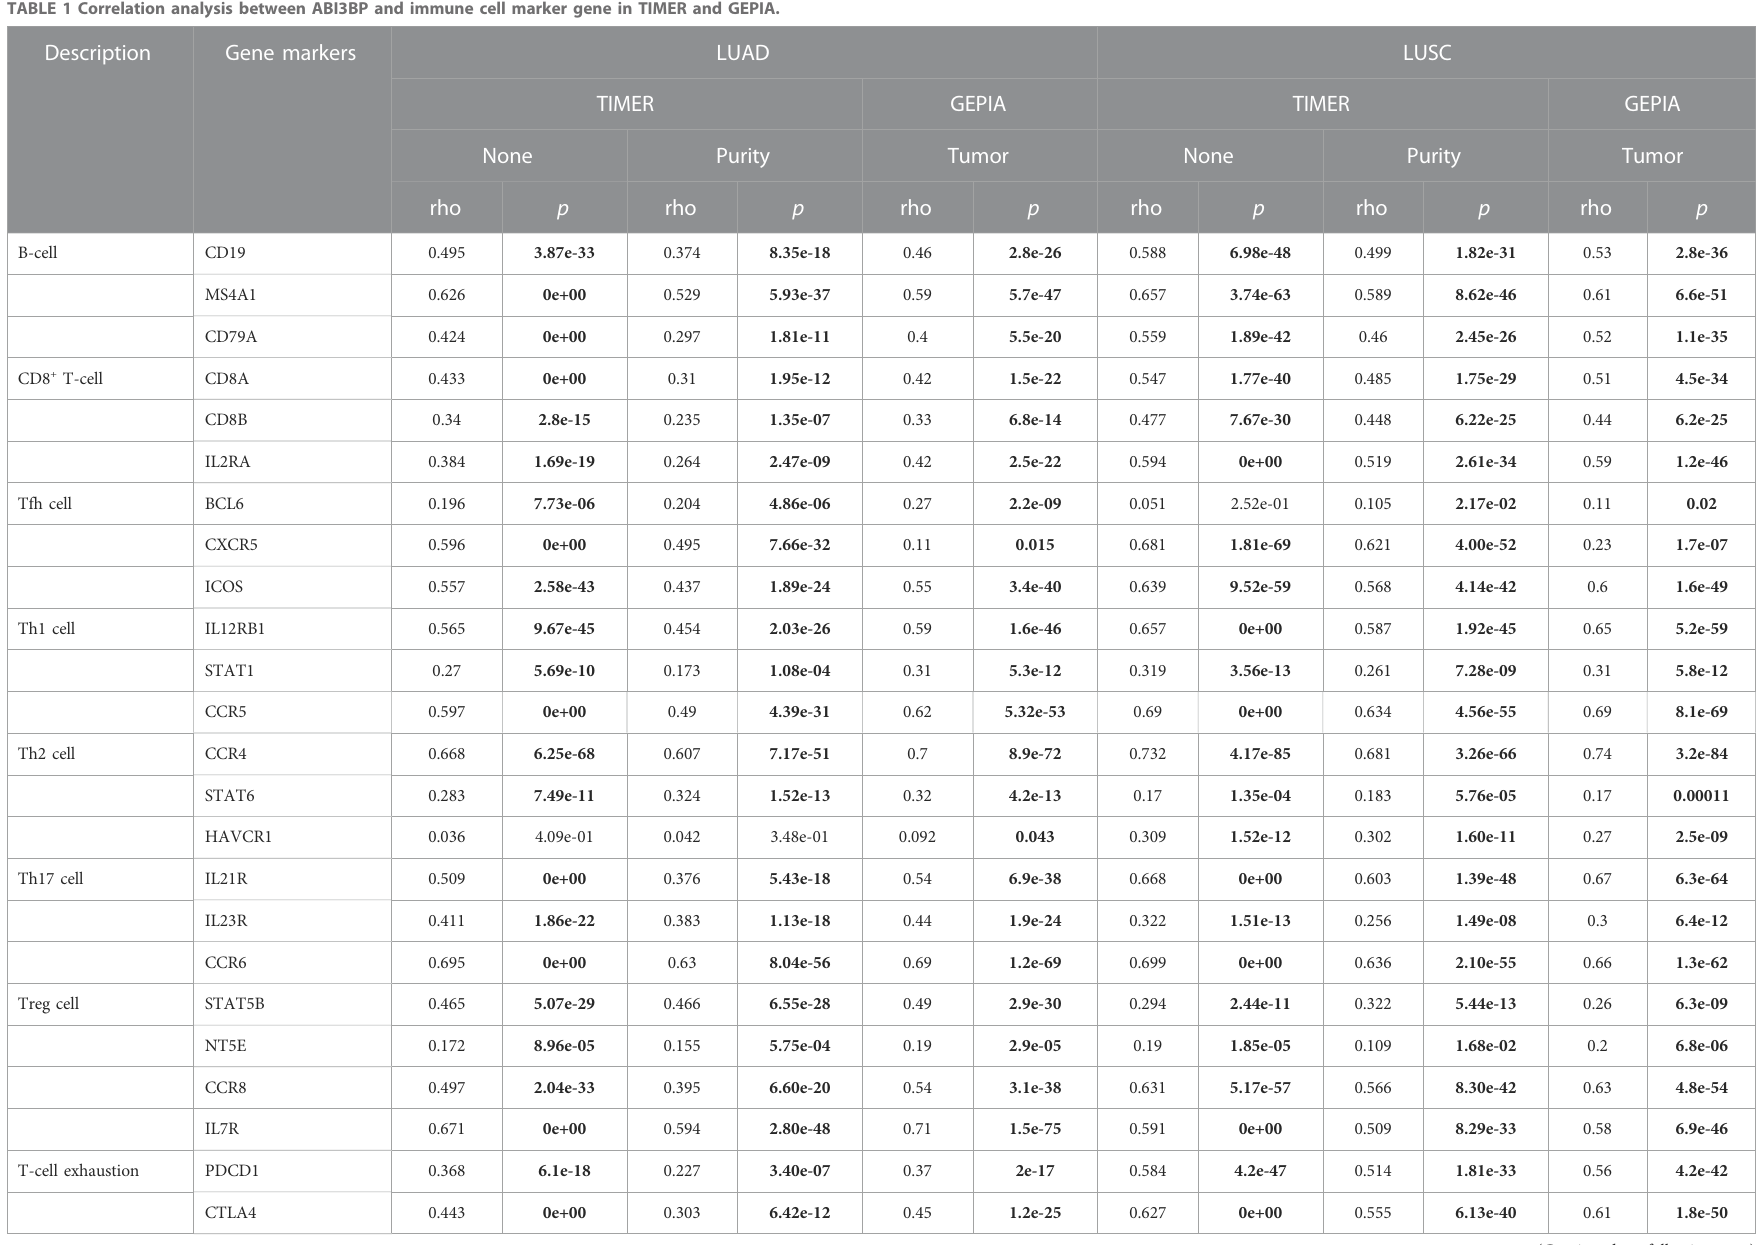
TABLE 1 Correlation analysis between ABI3BP and immune cell marker gene in TIMER and